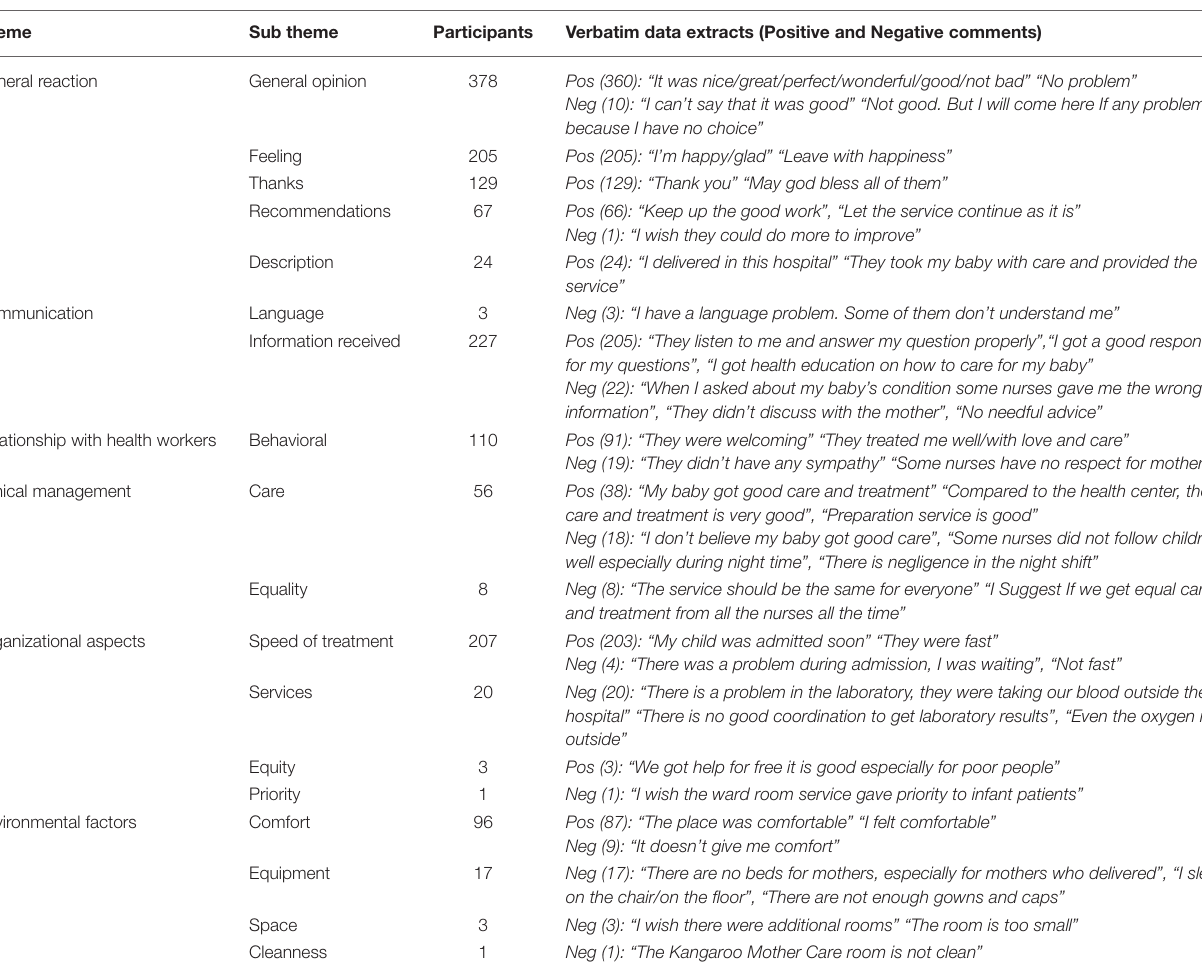
TABLE 7 | Themes and selected verbatim responses to open questions about parents’